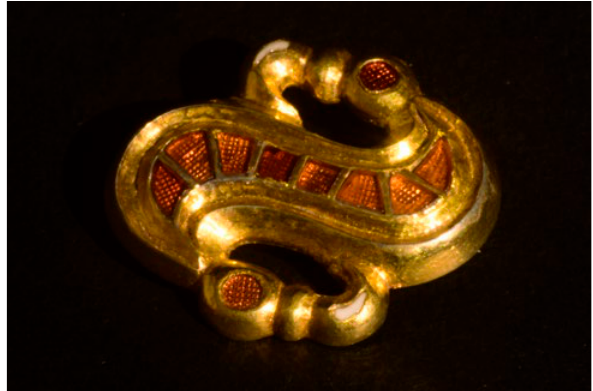
Figure 2. Fibula in gilded silver, garnets and bone. Length 3 cm. Technique: cuttlefish bone fusion, pure gold leaf gilding. Author: Alessandro